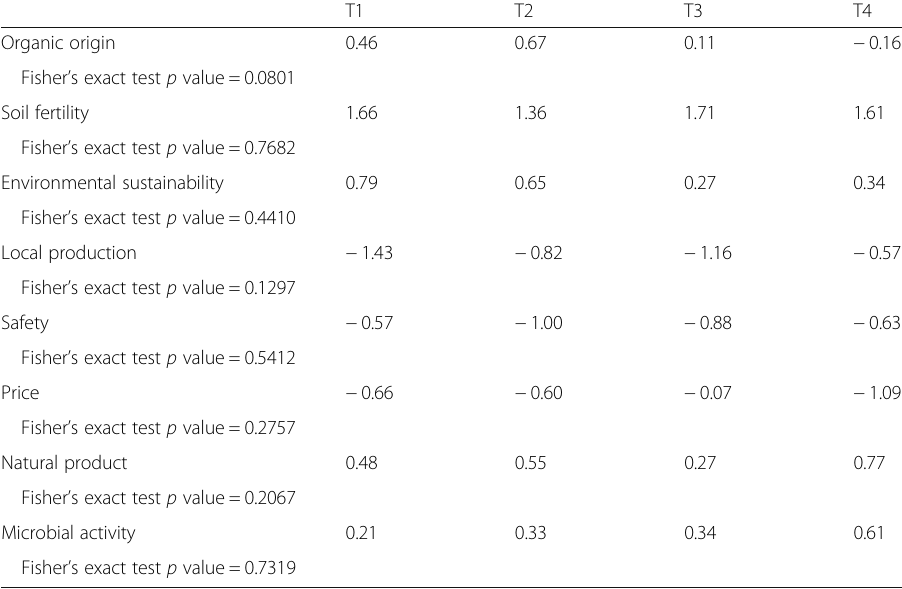
Table 5 Statistics of best – worst scores for soil conditioners ’ attributes T1